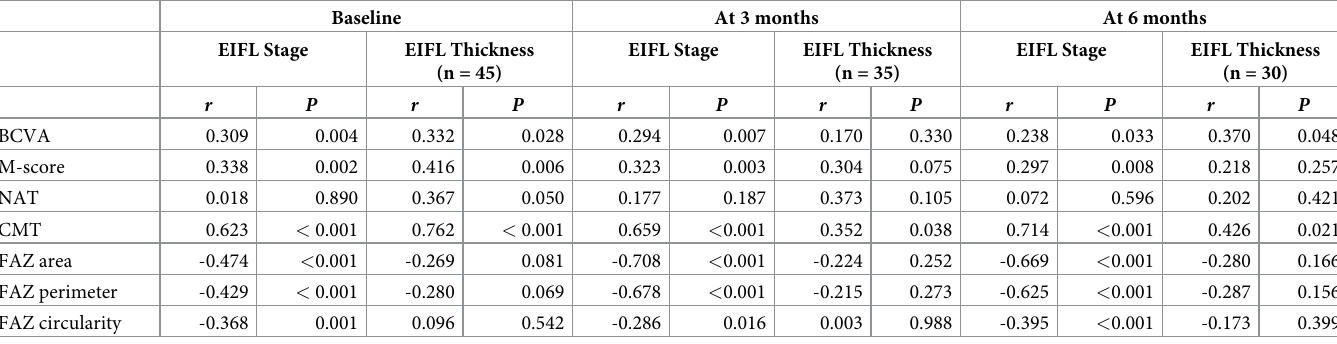
EIFL, ectopic inner foveal layer; BCVA, best-corrected visual acuity; M-score, M-chart score; NAT, New Aniseikonia Test score; CMT, central macular thickness; FAZ, foveal avascular